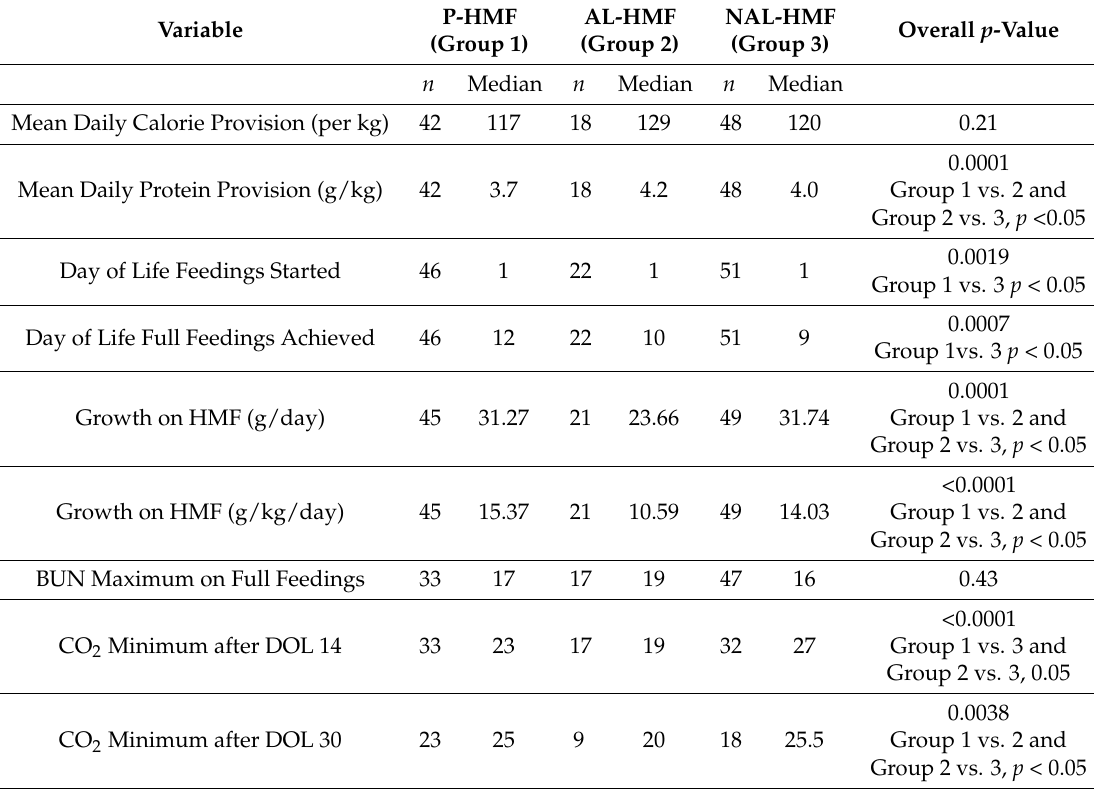
Table 4. Laboratory, growth, and enteral nutrition